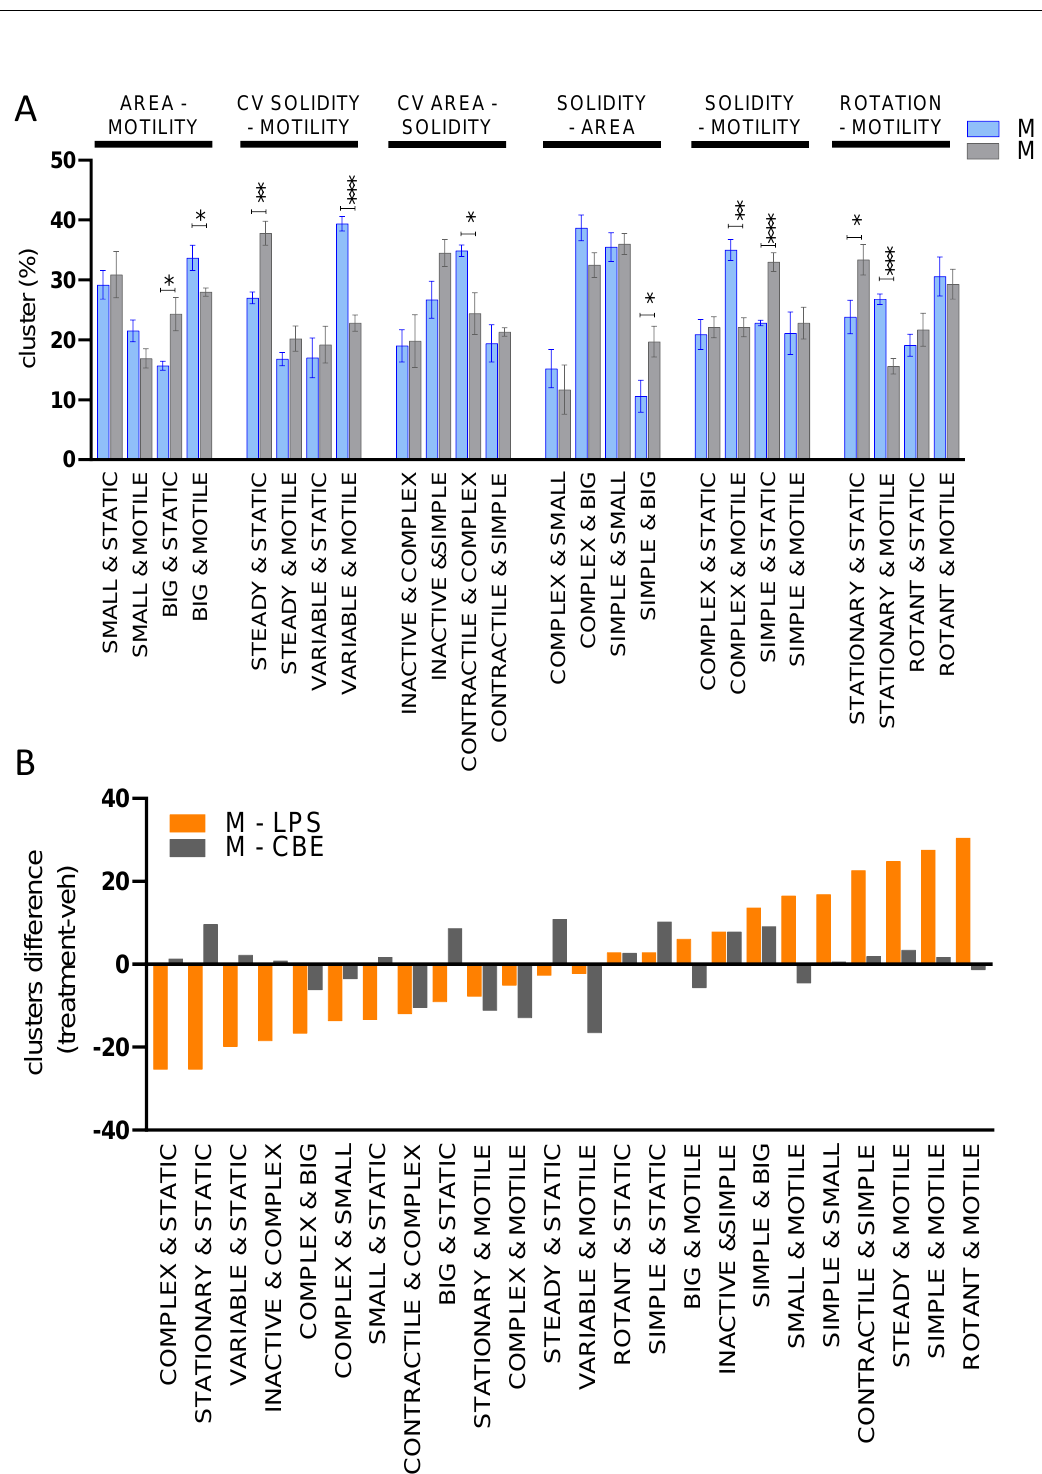
Figure 4. Morpho-functional biparametric analysis of CBE-treated male microglia. ( A ) Biparametric analysis is represented as a histogram of the median ± SEM of the subpopulation percentage obtained in 4 different experiments, the two parameters obtained to generate the clusters are reported on the top of the graph; * p < 0.05, ** p < 0.01, *** p < 0.001 calculated by t -test versus vehicle. ( B ) Variation in subpopulation composition for LPS (Figure 2B) and CBE ( A ) treatment versus the vehicle-treated cells.